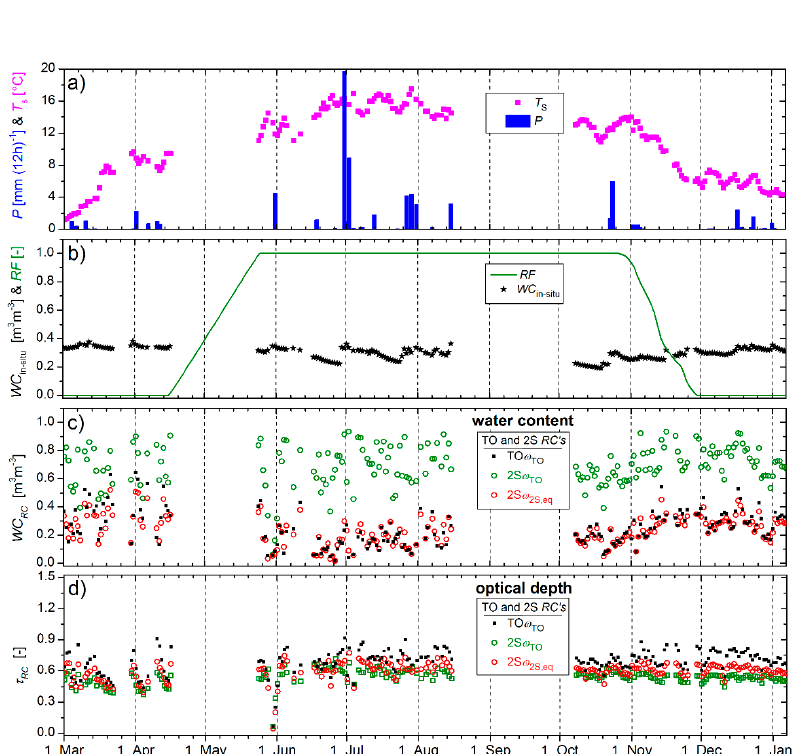
Figure 6. Time series of ( a ) in-situ soil temperature T s (magenta squares), and precipitation P (blue columns); ( b ) Relative Foliation RF of the forest canopy (green line), and forest soil liquid Water Content WC in − situ (black stars). Time series of retrievals 2P RC = ( WC RC , τ RC ) computed from the p , θ j elevation scans T are shown in ( c , d ). Retrieval Configuration RC is indicated in the B